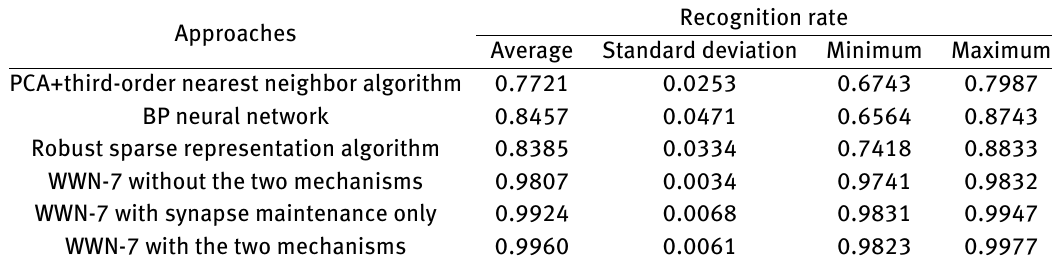
Table 6: Comparison of recognition rate for the 6 methods